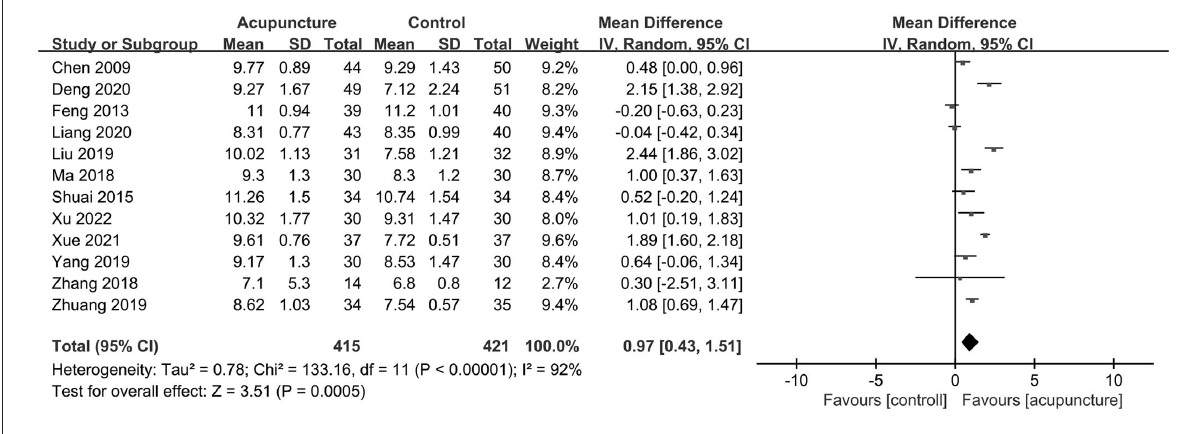
FIGURE6 Forest plot of endometrial